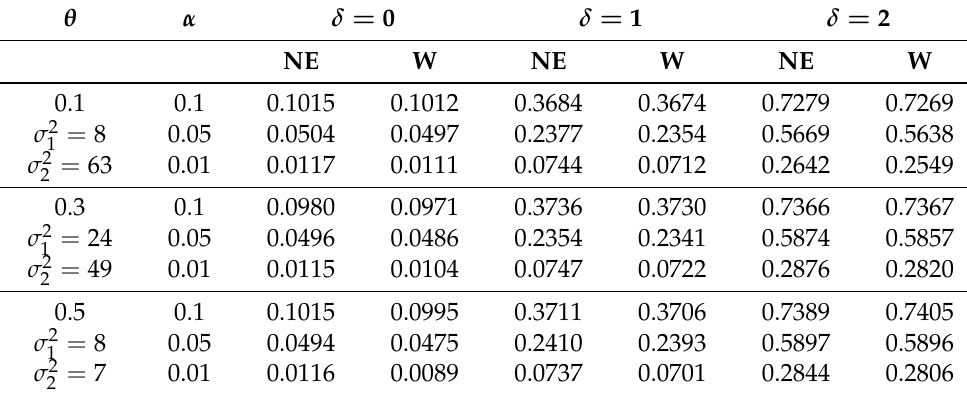
Table 5. Power values for ( n 1 , n 2 ) = ( 8,7 ) .